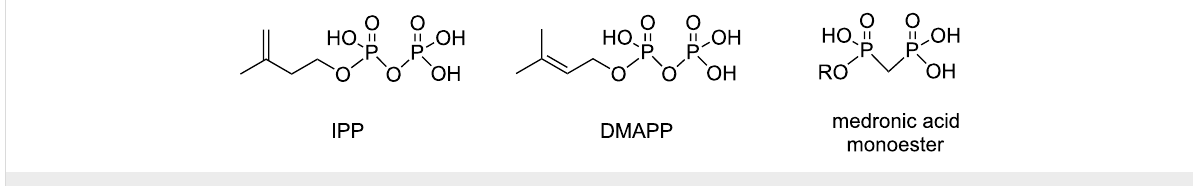
Figure 1: Structures of isopentenyl pyrophosphate (IPP), dimethylallyl pyrophosphate (DMAPP) and the general structure of medronic acid monoesters.